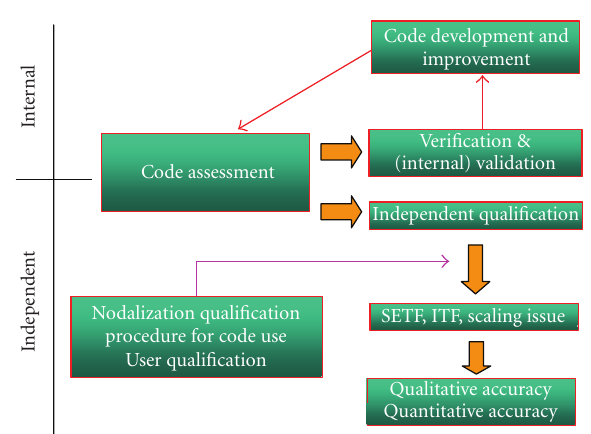
Figure 3: Internal and external (independent) code